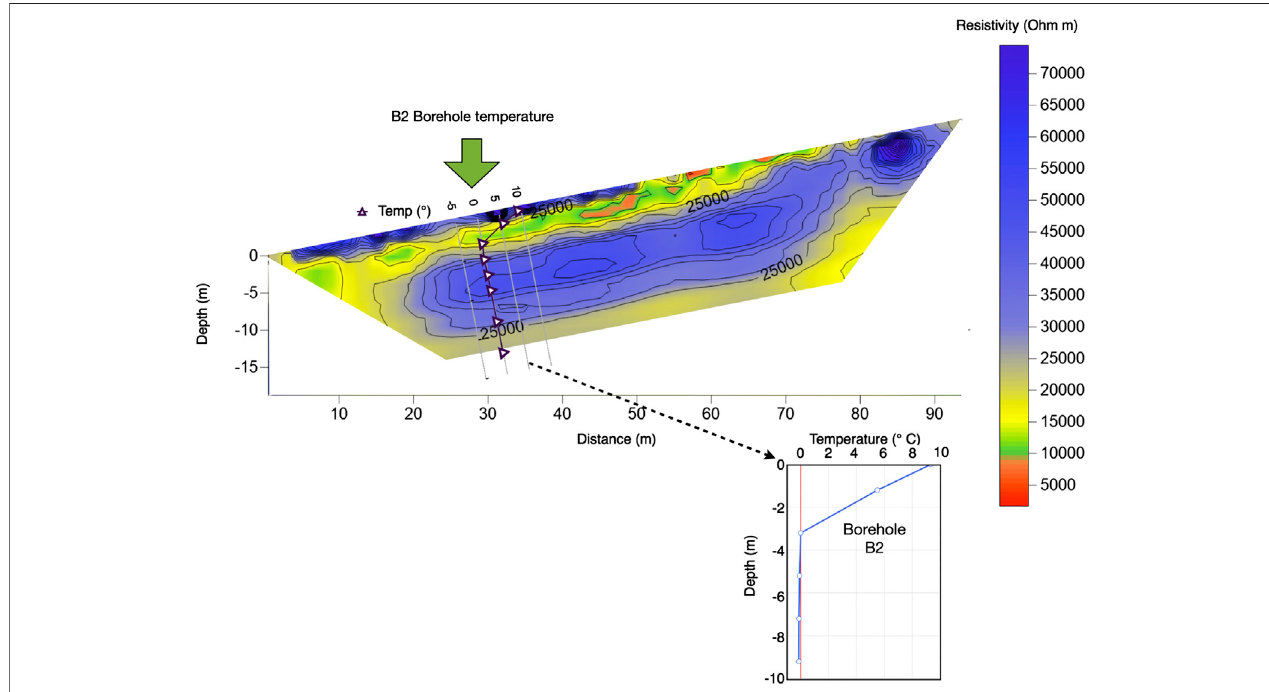
FIGURE 4 | ERT line at Schafberg B2 on July 30, 2019. The thick black line shows the position of borehole B2, the lower panel shows the mean daily borehole temperatures on the same day. A very high resistivity layer is visible below 3 m depth and most likely indicates ice-rich permafrost.